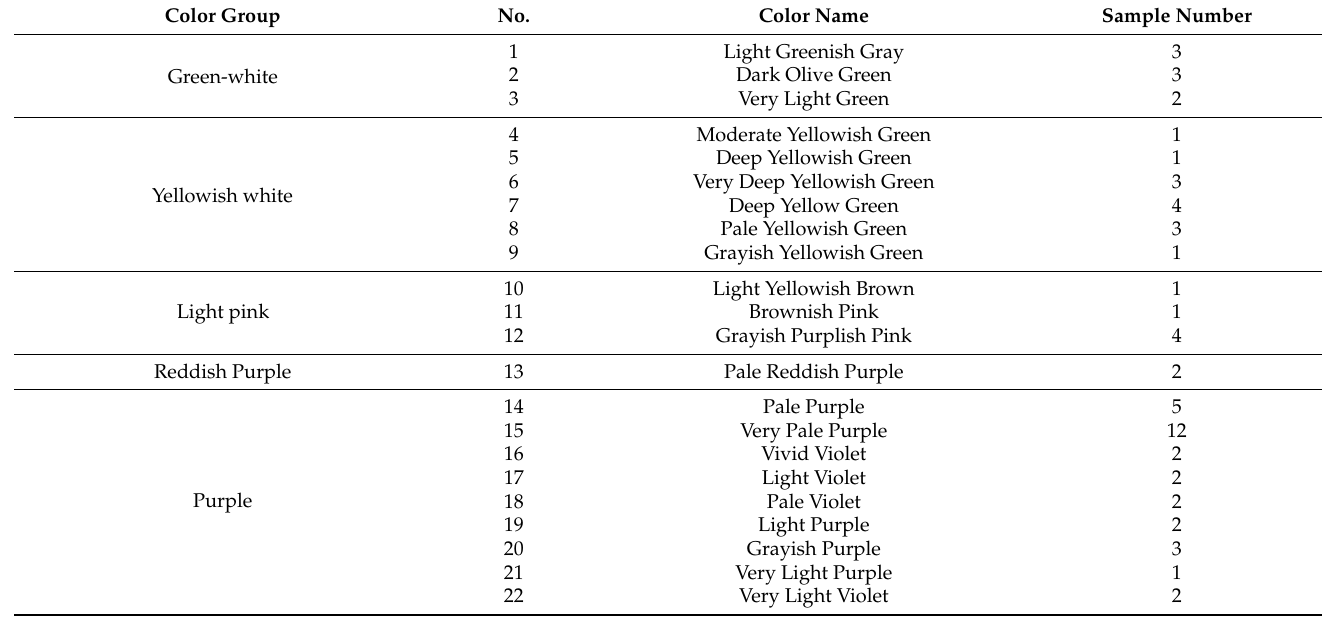
Table 5. The classification of L. chinense var. rubrum samples based on ISCC-NBS method of designat- ing colors.